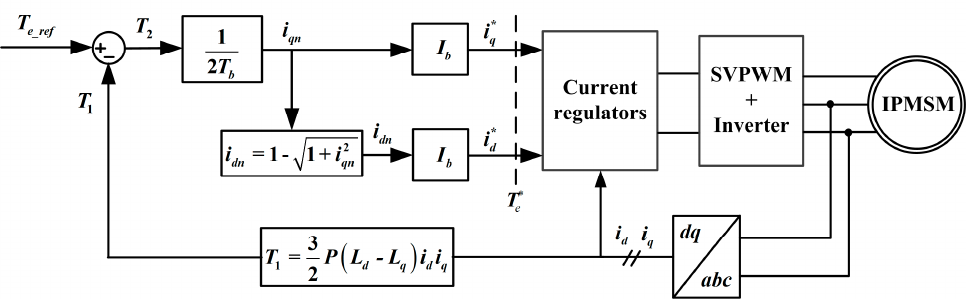
Figure 1. The torque control strategy structure with maximum-torque-per-ampere (MTPA) conditions. For the sake of simplicity, the per unit model is used in this strategy. Combing (2) and (4), i qn is equal to T 2 /2 T b . Once i qn is given, the per unit value i dn in MTPA condition can be solved as follows.